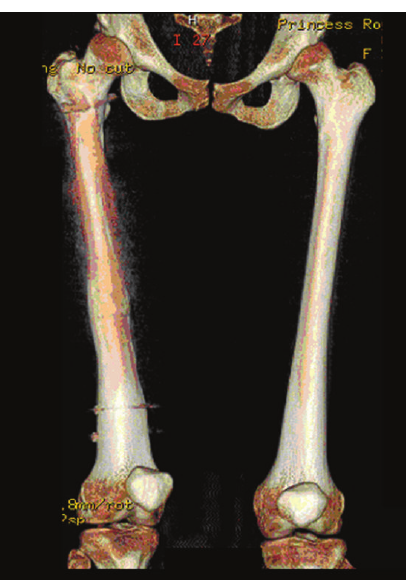
Figure 1: CT reconstruction showing rotational deformity of the right femur.